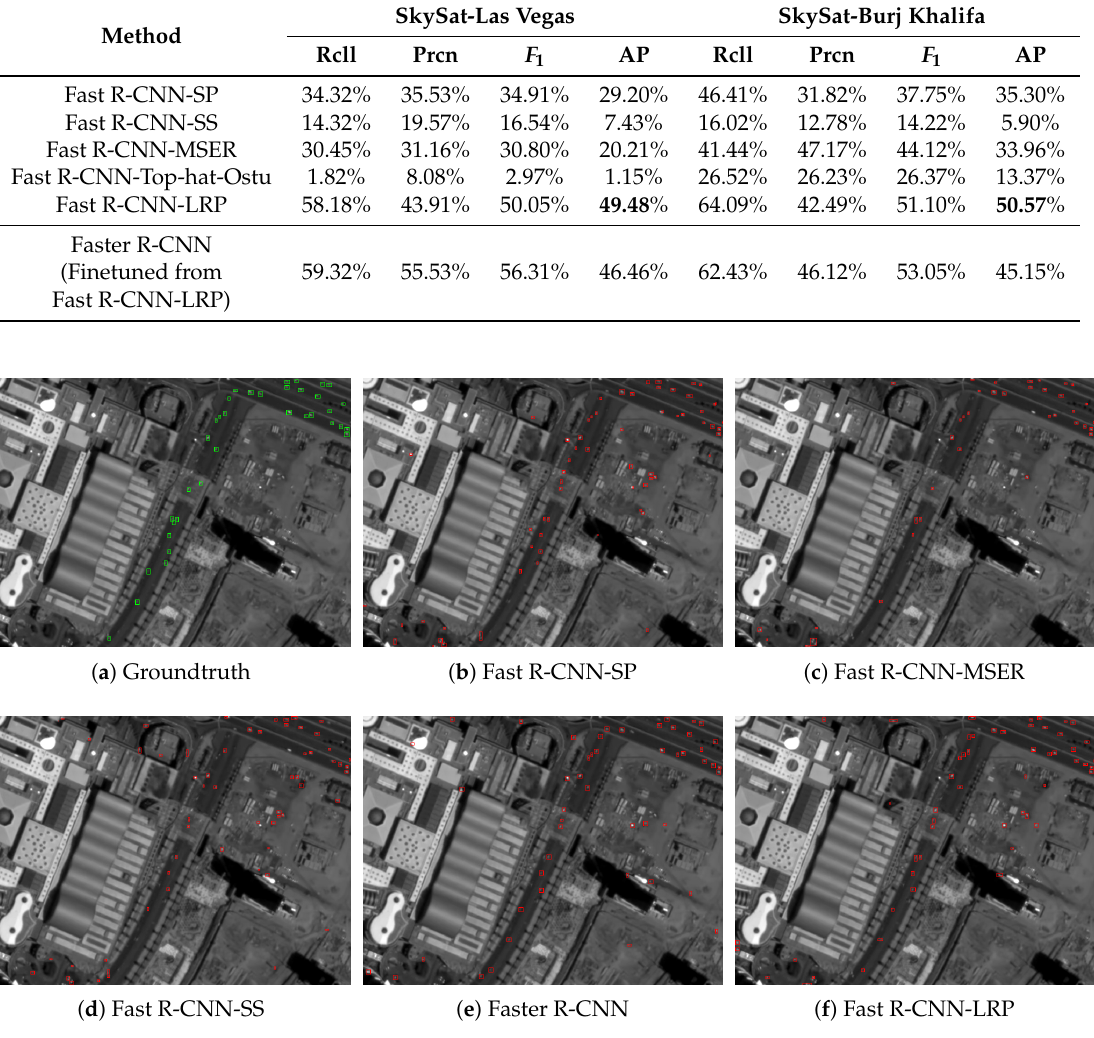
Table 4. Detection performance evaluation.